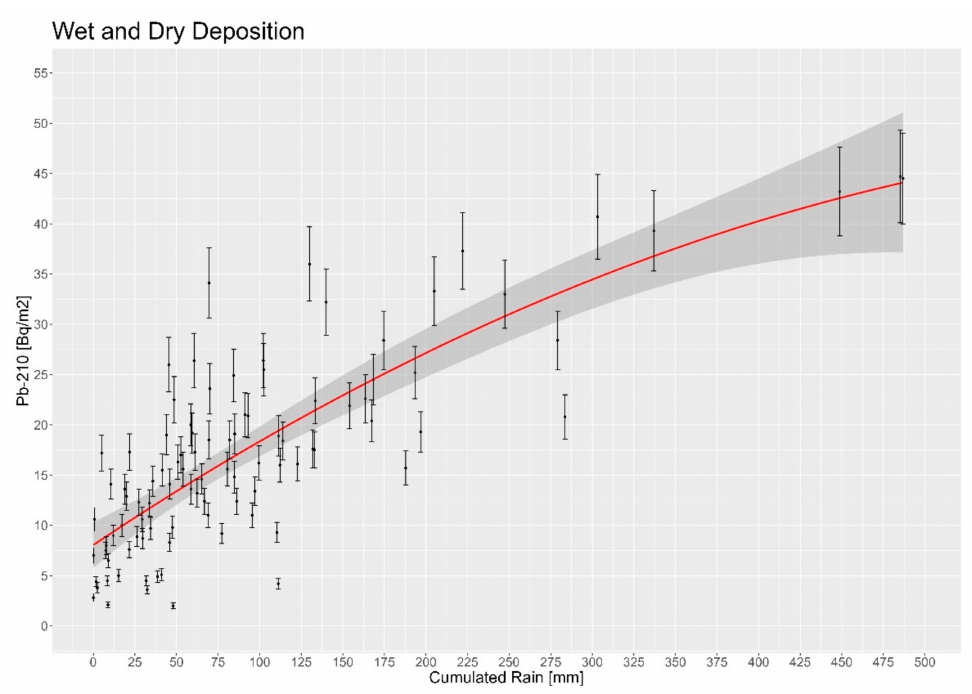
Figure 6. Interpolation (red line) of 210 Pb total deposition as a function of the rain cumulated during the sampling time: the grey darker area indicates the interval of confidence of the curve